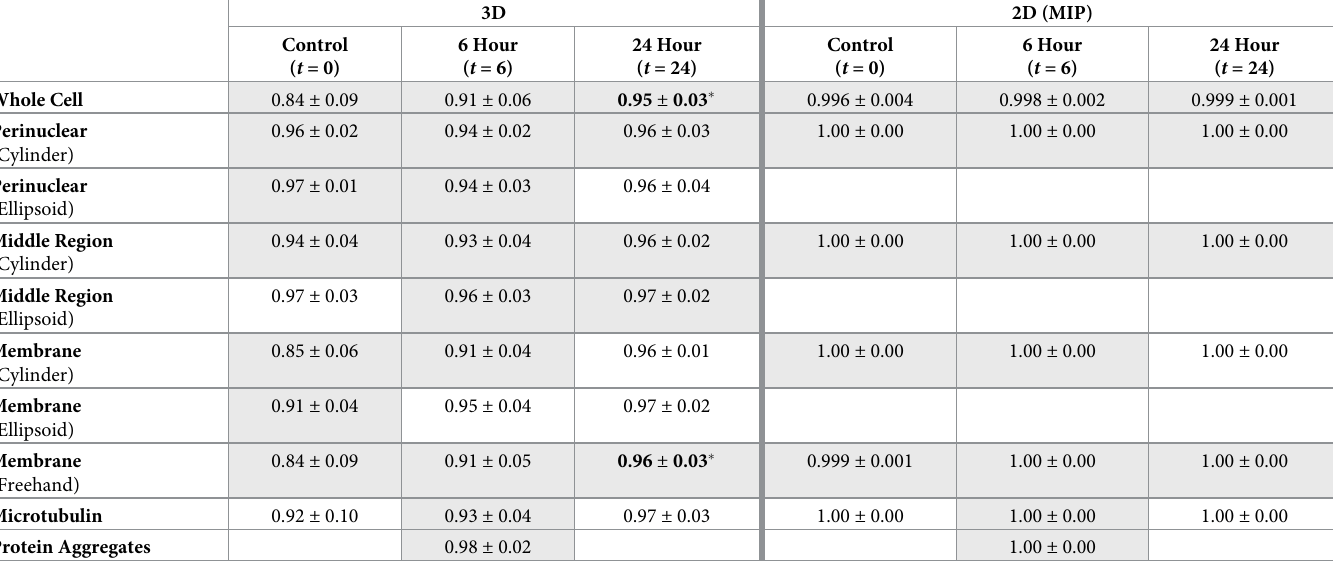
The analysis of MCC reveals that, when calculated using 2D MIP, many colocalization esti- mates equal unity. When the MIP is generated, only the maximum intensities are projected and therefore the less-colocalized (lower) intensities are lost. This leads to the summation of the same intensities in the numerator and in the denominator of Eqs 3 and 4 and a resultant MCC of unity. When making the same selections in 3D, all voxels, including those which are dimmer and considered less-colocalized, are taken into account, leading to variations in the calculated MCC. This indicates that the 3D metric is more sensitive to variation in the data Table 4. Manders’ correlation coefficient for Tau (M1) with procedure described in Table